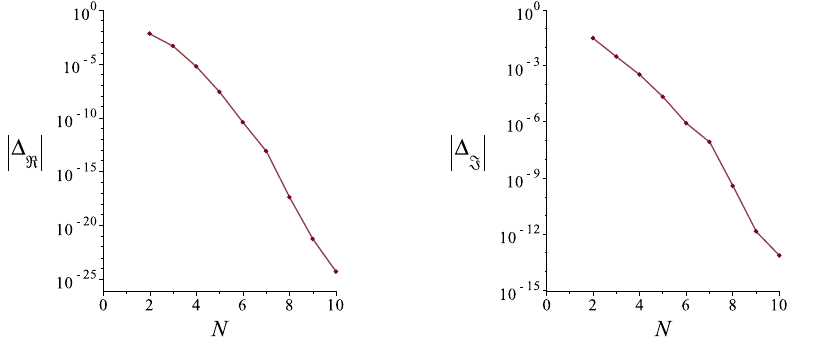
Figure 7 . Comparison of the nonperturbative result Z N + i Borel resummation S + ( Z full ) (blue solid line) at g s = 2. The real part (left) and the imaginary part (right) are plotted separately.